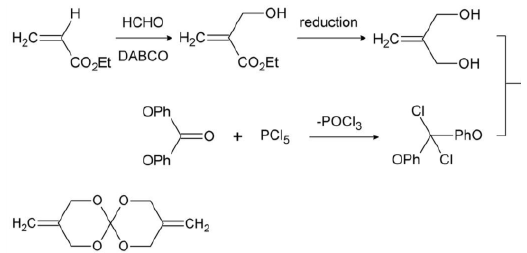
Scheme 1. The main synthetic steps of BMSOC.